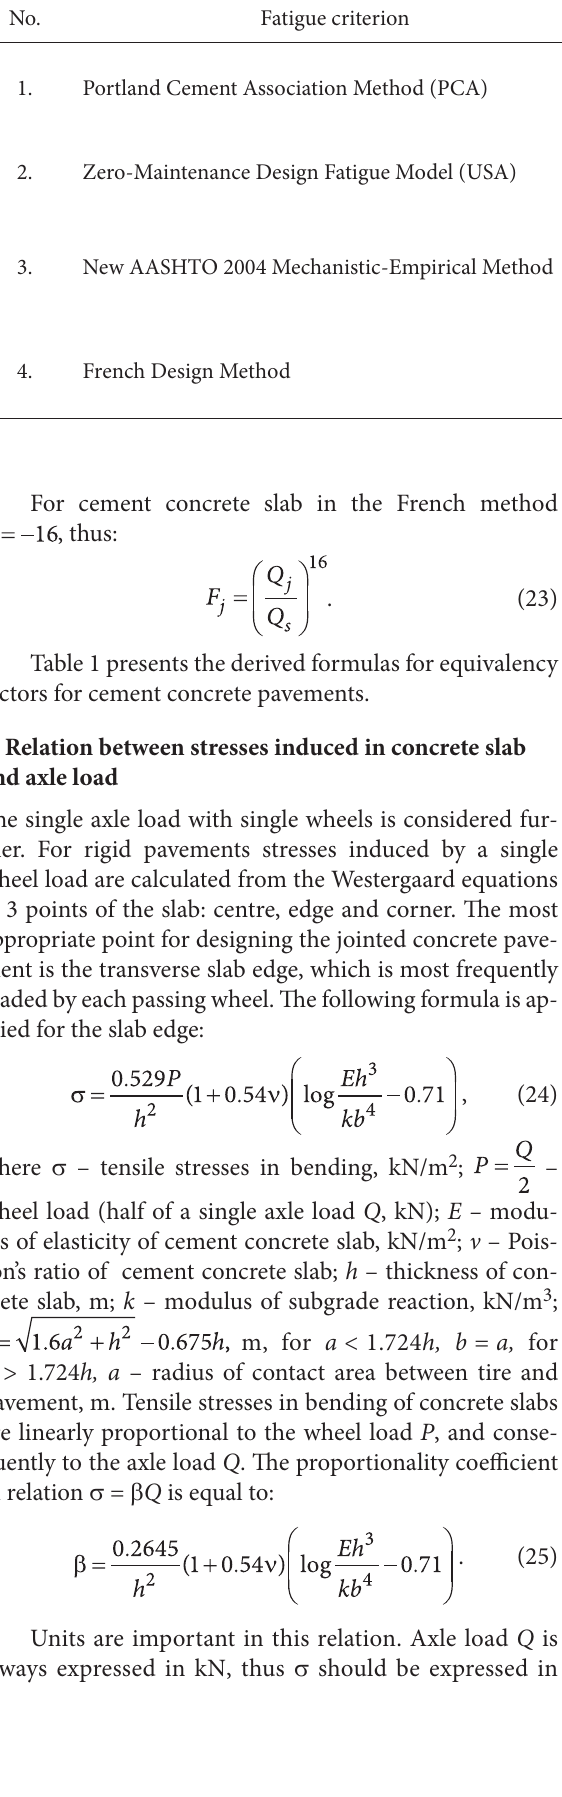
Table 1. Derived formulas for equivalent axle load factors F j No. Fatigue criterion Equation for equivalent axle load factors F